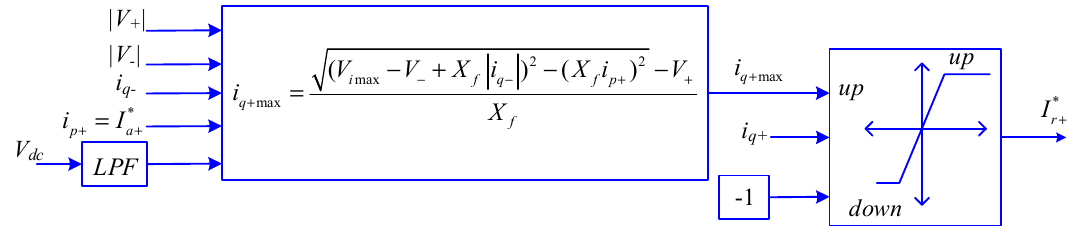
Figure 9. Anti-saturation scheme considering positive and negative sequence current references.